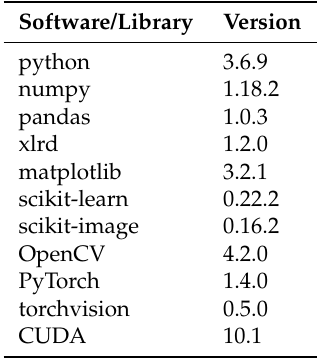
Table 2. Software packages and versions